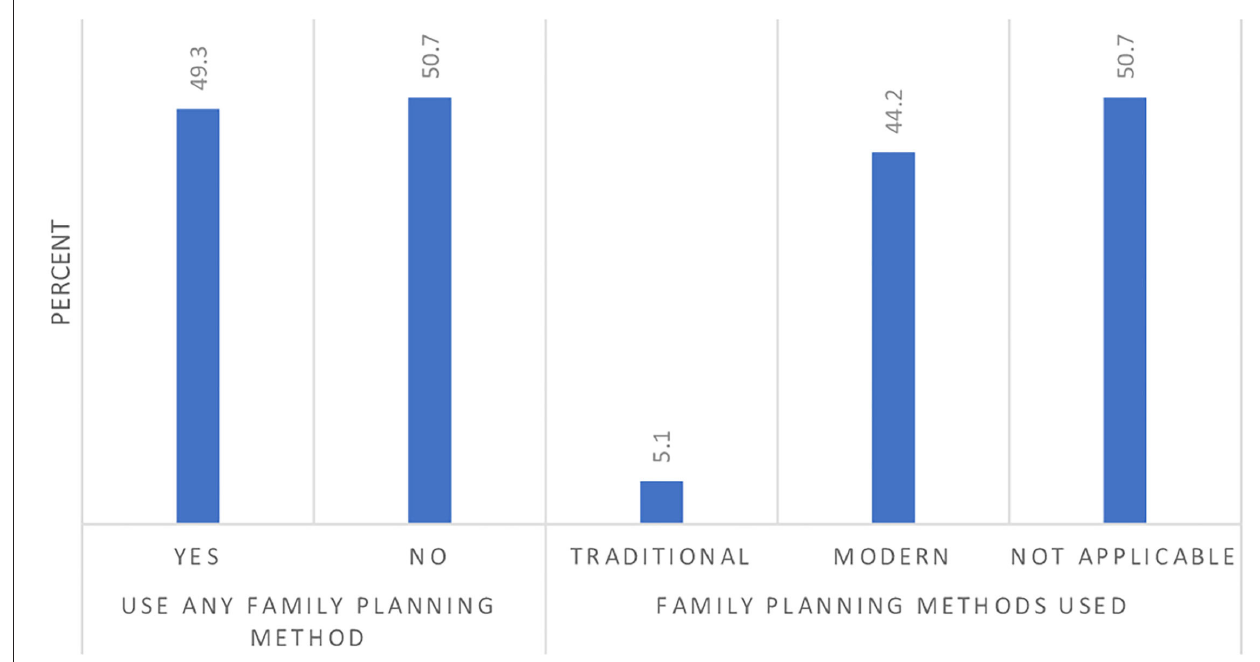
FIGURE 1 | Use of family planning methods by the Ugandan youth during the COVID-19 lockdown.